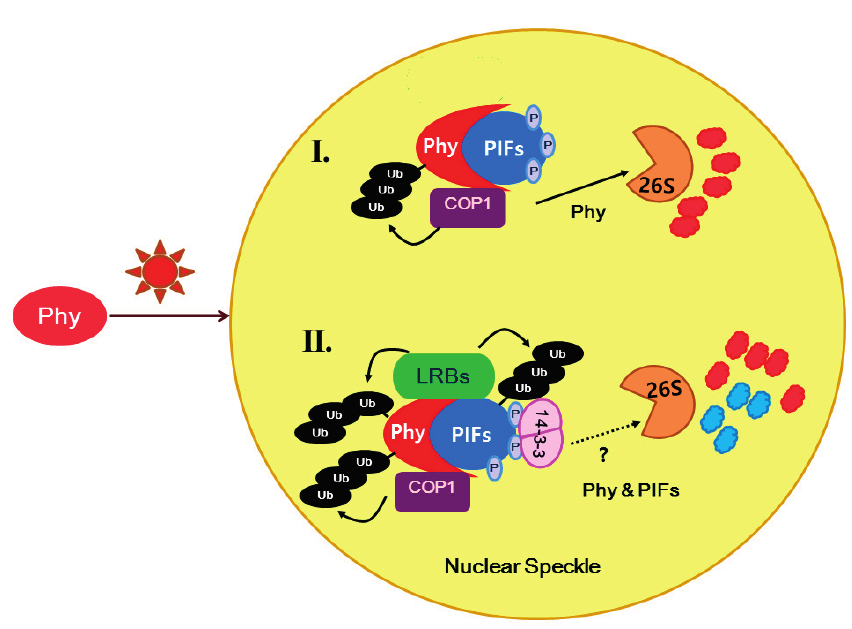
Figure 4. Model for the mode of action of 14-3-3 κ in the context of light signaling. I. Upon light illumination, phytochromes (Phy) rapidly convert to an active form